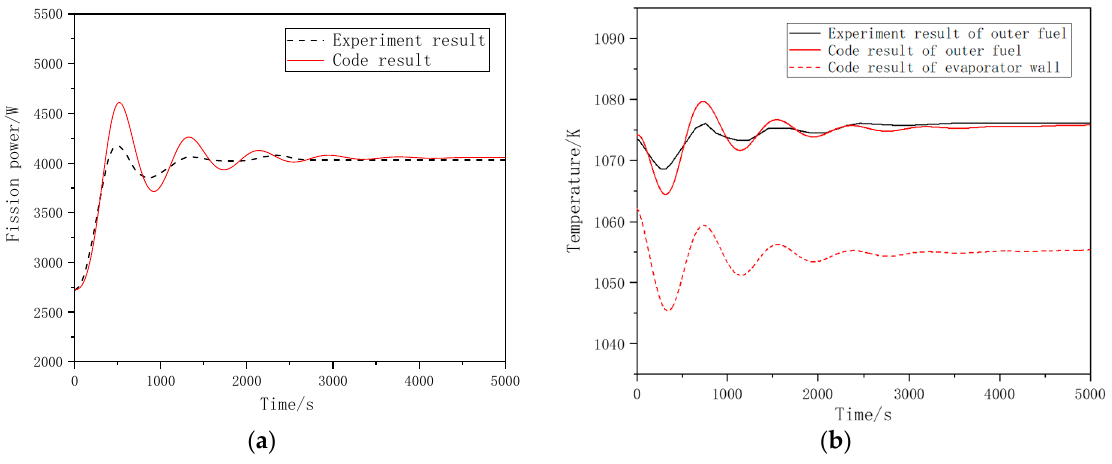
Figure 17. Core power and temperature variation under load increasing condition: ( a ) core power and ( b ) core temperature.